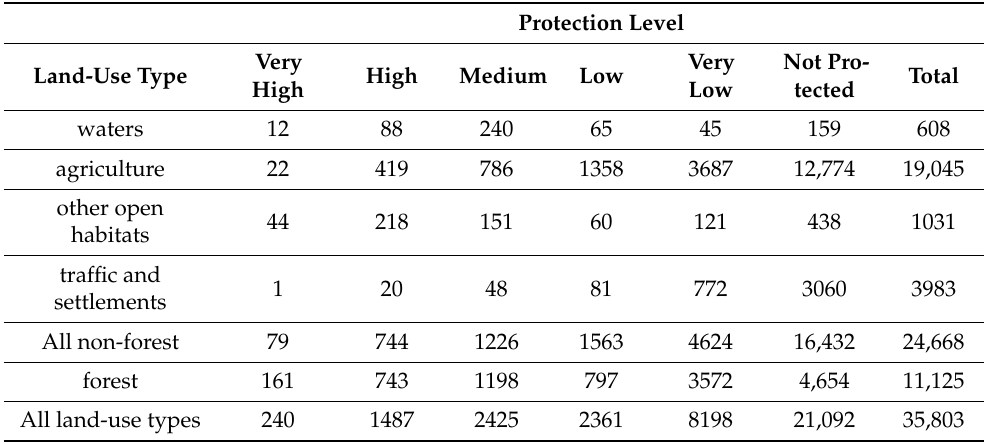
Table A3. Protected areas in Germany by land use categories in 1000 ha (Source: Röder and Laggner [32]). Protection